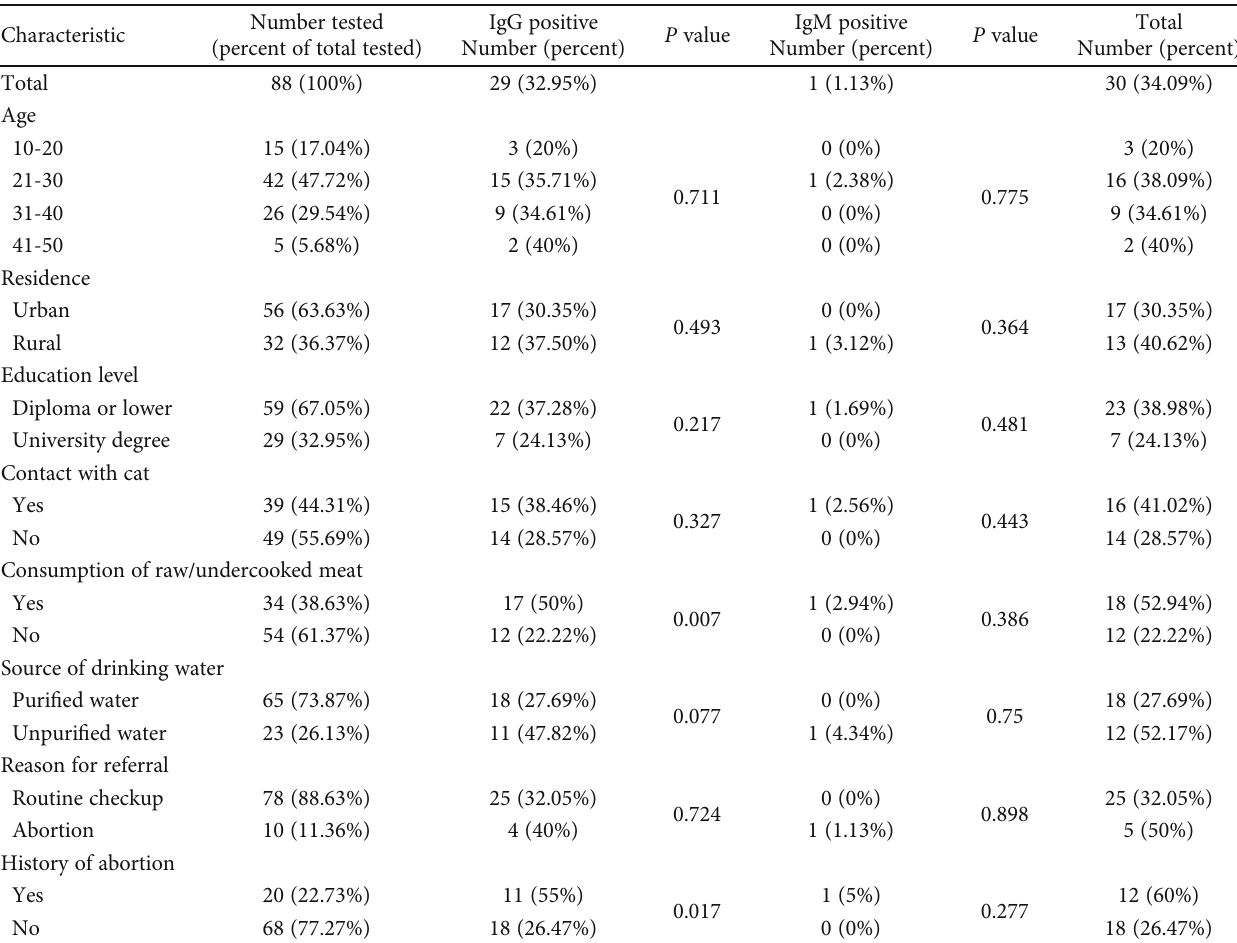
Table 1: Demographic characteristics and risk factors related to IgG (latent) and IgM (acute) seroprevalence of T. gondii in pregnant women in Abadan County, Khuzestan Province, Iran, from Oct. to Dec. 2019. P value < 0.05 indicates a signi fi cant di ff erence in seroprevalence between the categories within each